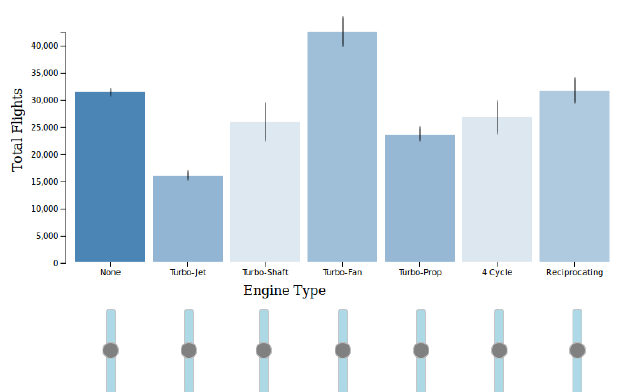
Figure 9. The interface used in the user study, to answer GROUP BY engine queries for the flight